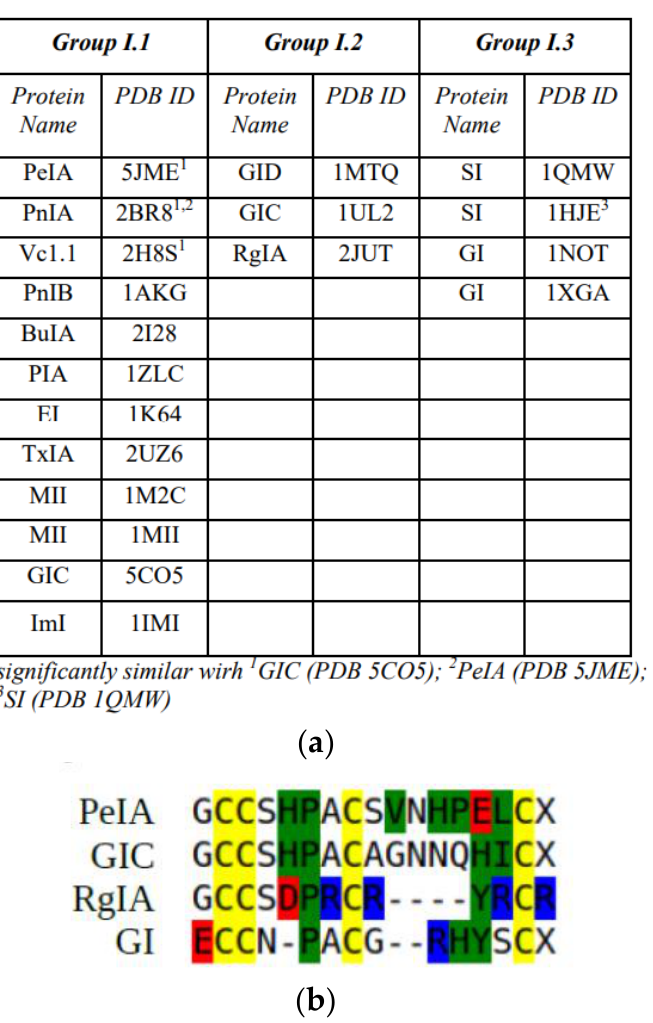
Figure A2. Different nAChRs found in muscle synapse: ( a )mostly in vertebrate and ( b ) mostly in invertebrate. Source: adapted from [35].